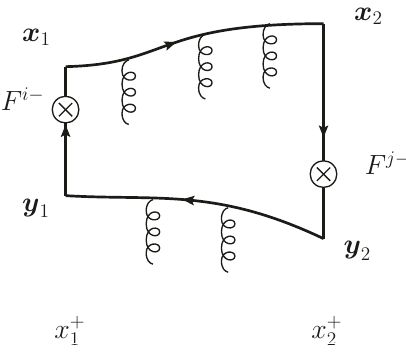
Figure 5 . Illustration of the generalized dipole operator U ij